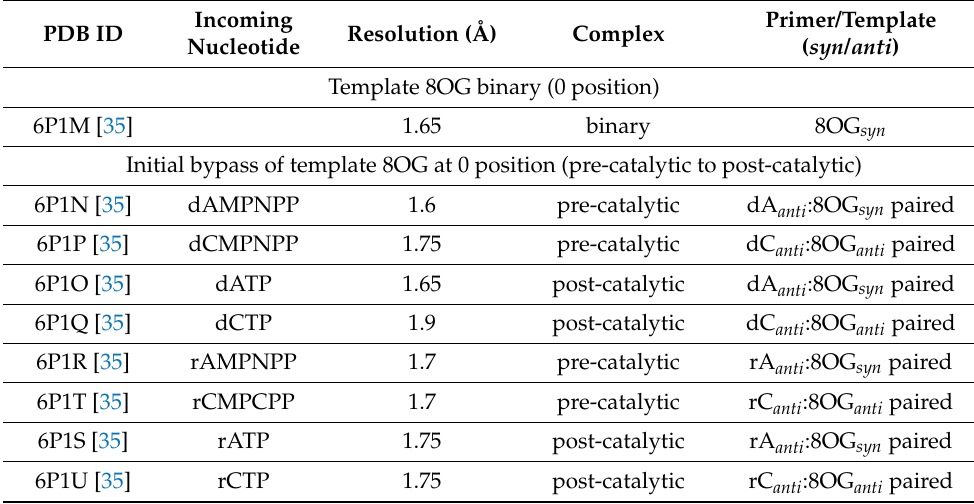
Table 3. X-ray crystal structures of template 8OG bypass by Pol µ